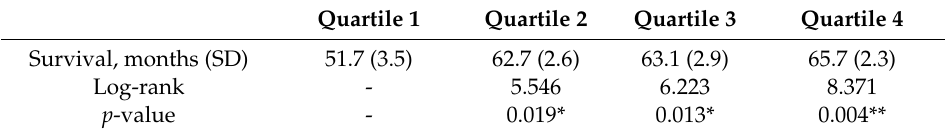
Table 6. Risk factors independently associated with mortality.